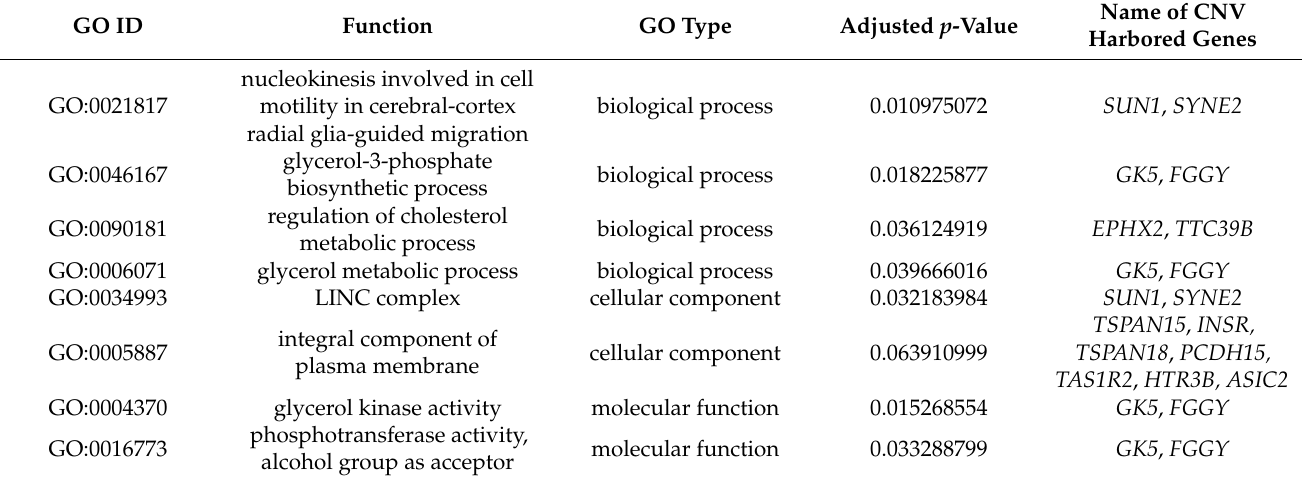
Table 3. The significant GO categories of CNVR-harbored